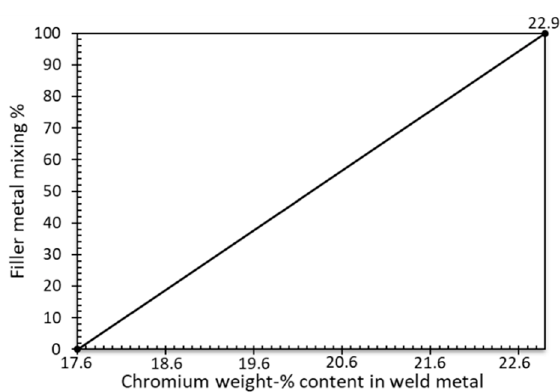
Figure 4. Relationship between chromium content in the weld metal and corresponding filler metal mixing-%. On the horizontal axis, 17.6 represents chromium weight-% content equal to the base metal and 22.9 is the chromium weight-% content of the filler metal.